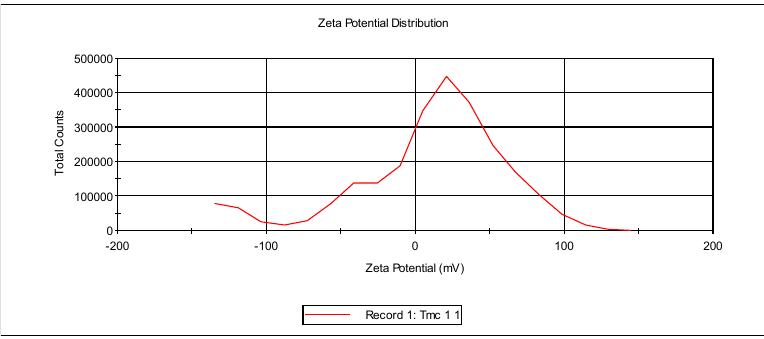
Fig. 1. The size distribution of D-glucosamine nanoparticle measured by Dynamic Light Scattering (DLS)